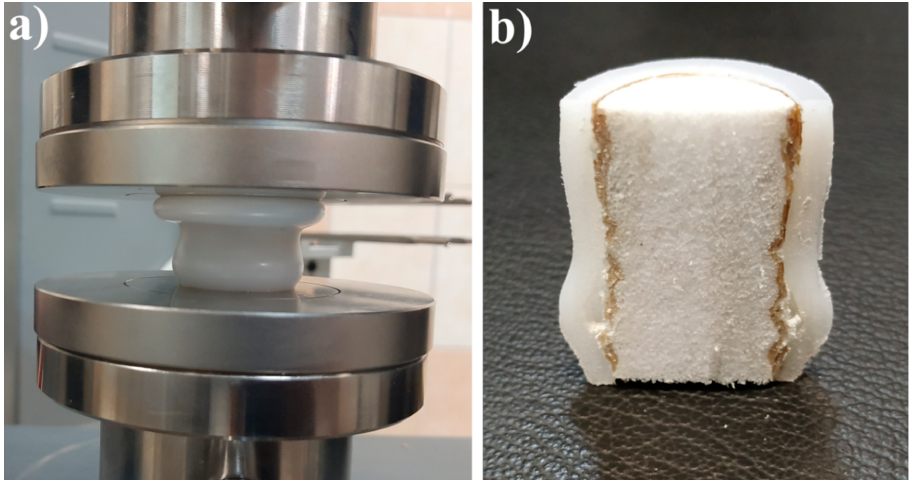
Figure 8. Multi-UHMWPE forms composite of bulk ( 1 ) and porous ( 2 ) UHMWPE.